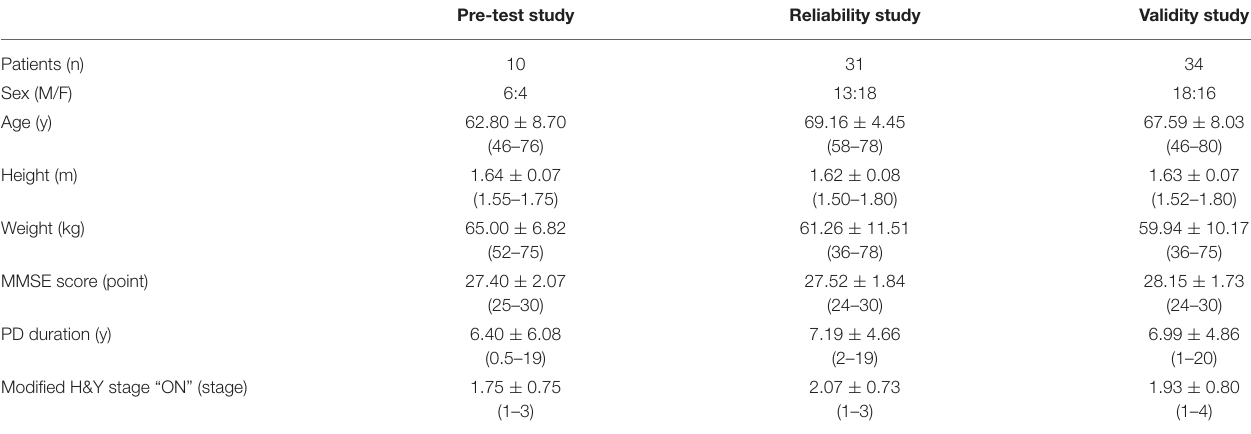
TABLE 1 | Demographic characteristics of patients with PD, Means